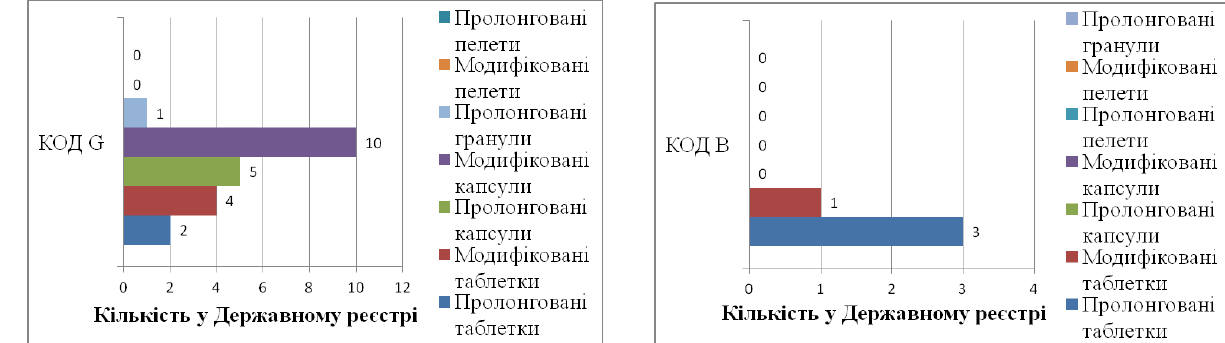
Рис. 6. Кількісна представленість ТОЛЗВД у Державному реєстрі (код G – Лікарські засоби для лікування захворю- вань урогенітальних органів та статеві гормони)